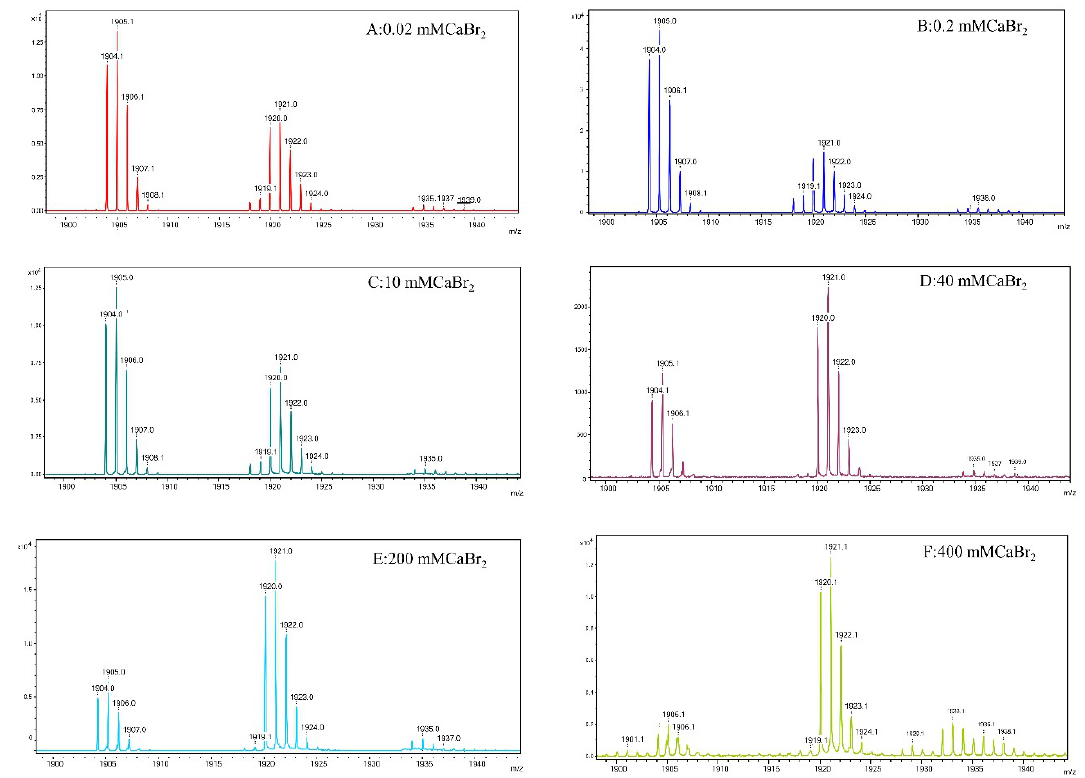
Figure 6. Mass spectra of gramicidin A in the presence of CaBr 2 . The samples containing 100 µ M gramicidin A with CaBr 2 at 0.02 ( A ), 0.2 ( B ), 10 ( C ), 40 ( D ), 100 ( E ) and 400 mM ( F ) in methanol were mixed with the matrix for mass analyses.